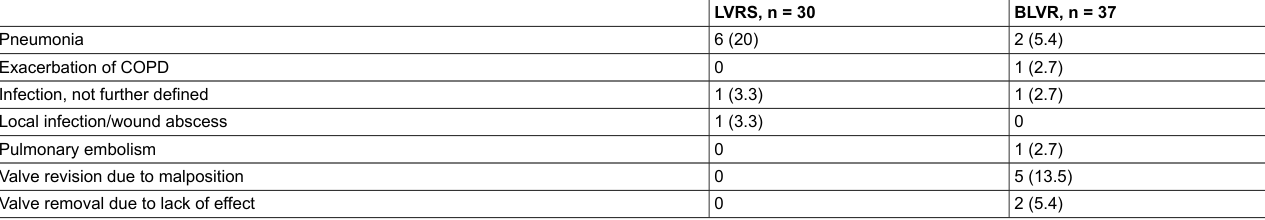
Table S4: Reasons for re-hospitalisations after lung volume reduction divided by